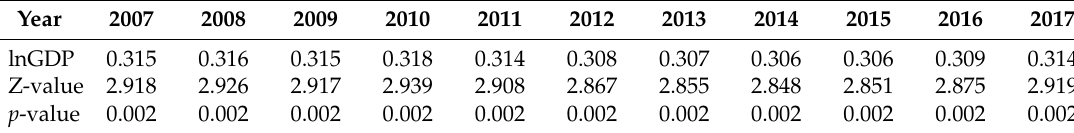
Table A3. lnGDP Moran’s I in China from 2007 to 2017.